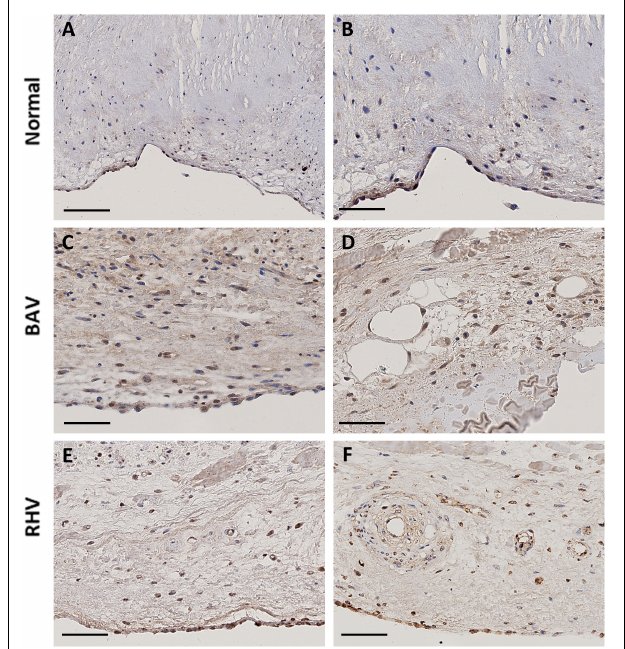
FIGURE 4 | The expression of HIF1 α in a normal cusp (A,B) , BAV (C,D) , and RHV (E,F) . Scale bar is 100 µ m in panel (A) and 50 µ m in all other